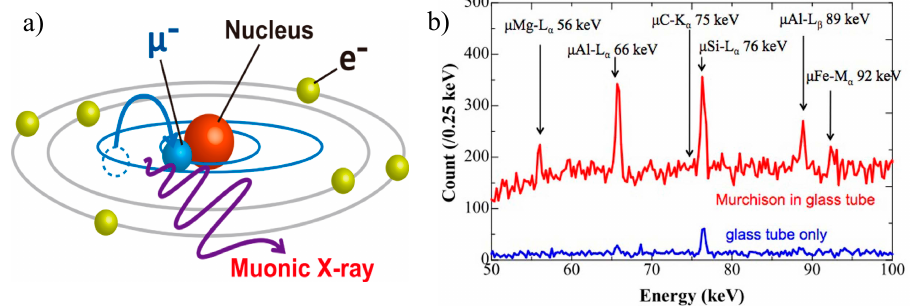
Figure 20. ( a ) Schematic illustration of the formation of a muonic atom, an atomic system that has a negatively charged muon in place of an electron. The element-specific X-ray is emitted upon successive transitions of muons to the lower-energy muonic orbitals. ( b ) Muonic X-ray spectra from the powdered Murchison meteorite in a SiO 2 glass tube. A clear signal of Mg and a marginally resolved signal of Fe from the sample were detected through the 1-mm thick SiO 2 glass wall [38].